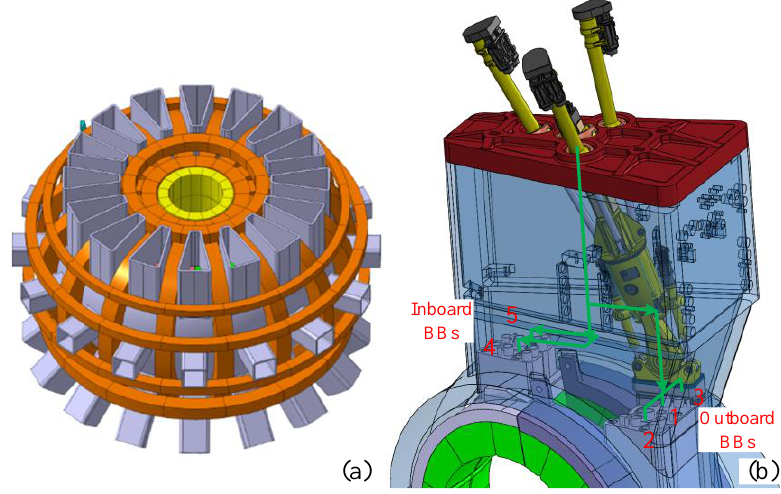
Figure 1. DEMO concept design ( a ); the process of HKM lifting the BBs ( b ).